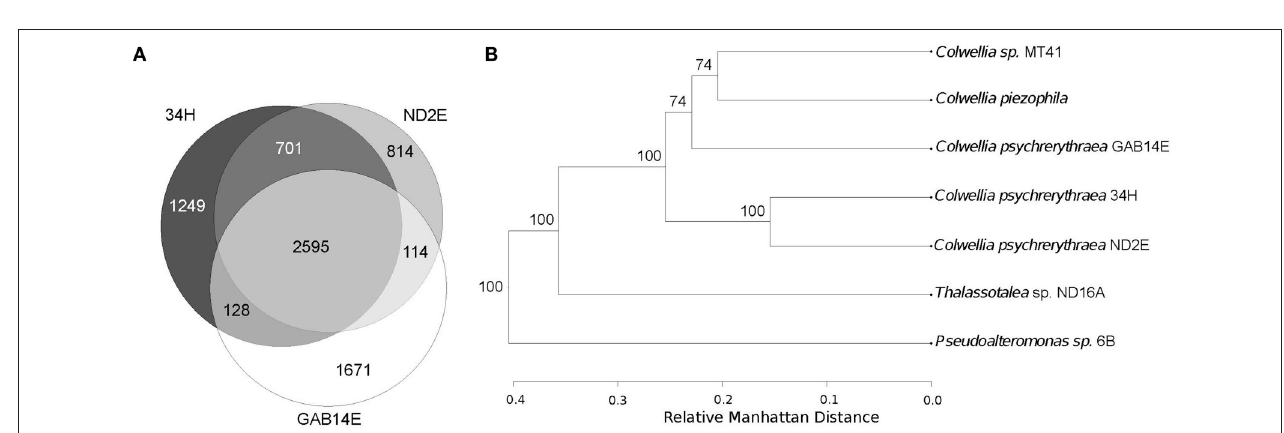
FIGURE 4 | Genomic Comparison. (A) Venn Diagram showing shared protein families between the three strains. (B) Whole genome tree based on relative manhattan distances of similarities of genes families. Bootstrap values of greater than 50% are shown at the nodes of the branches.